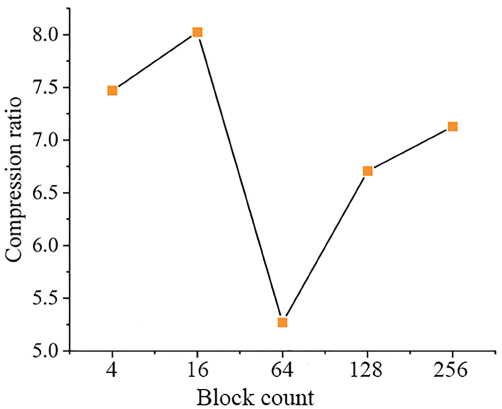
Figure 2. The relationship between the block count and the com- pression